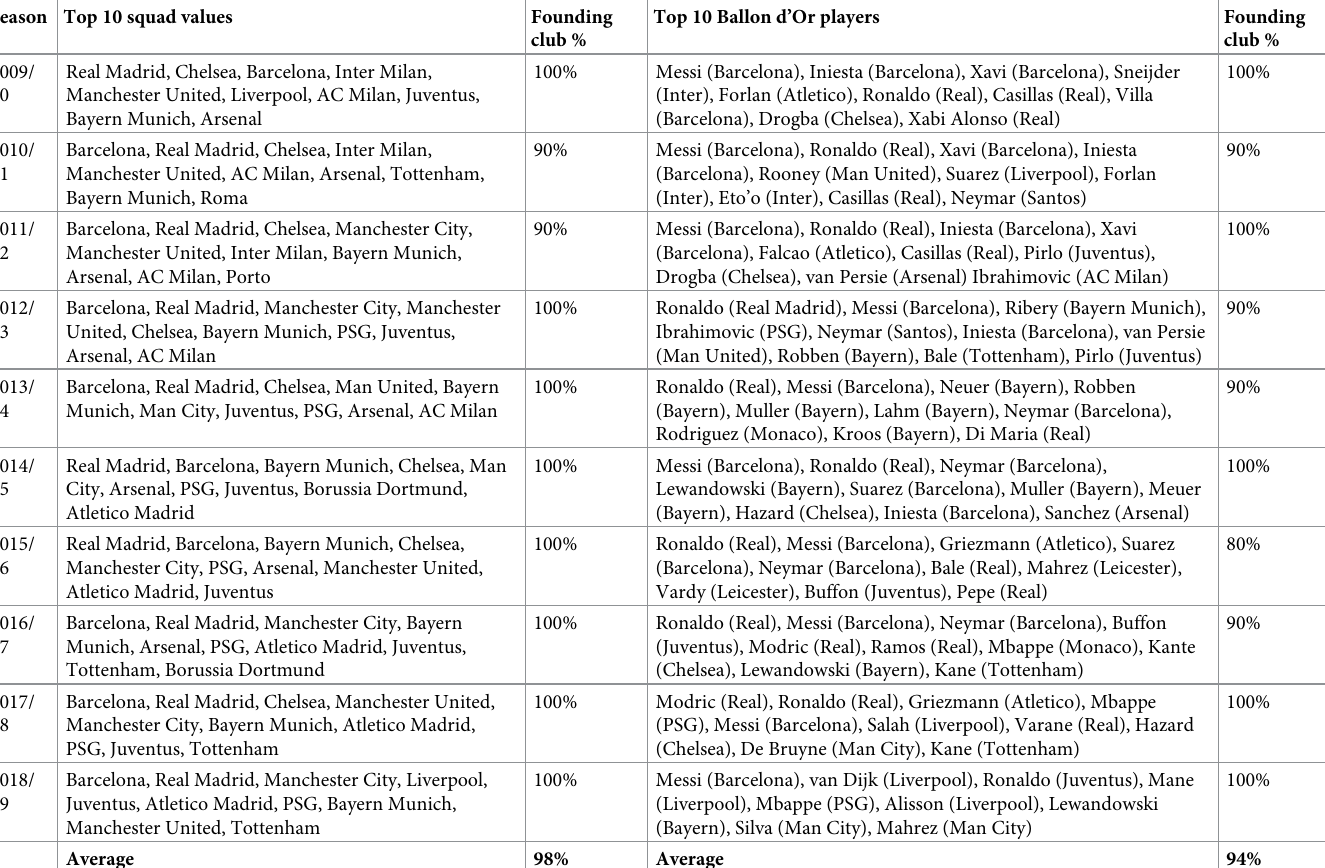
Table 5. Top 10 squad values and Ballon d’Or players by